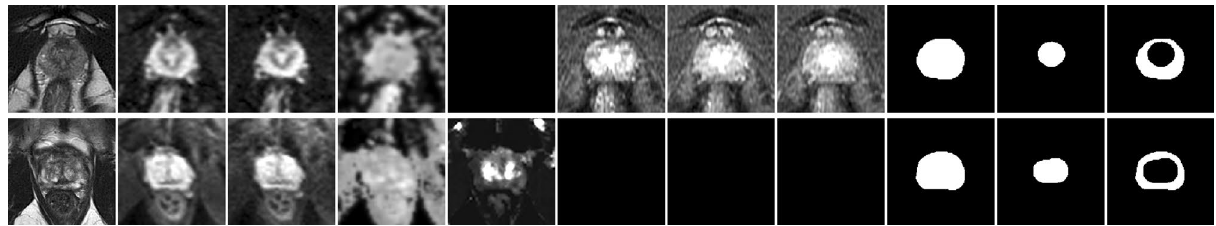
Figure 3. Final pre-processed image from a single patient (top: IVO, bottom: ProstateX). Channels (from left to right): T2, b400/b500, b800/b1000/b1400, ADC, K CG mask and PZ